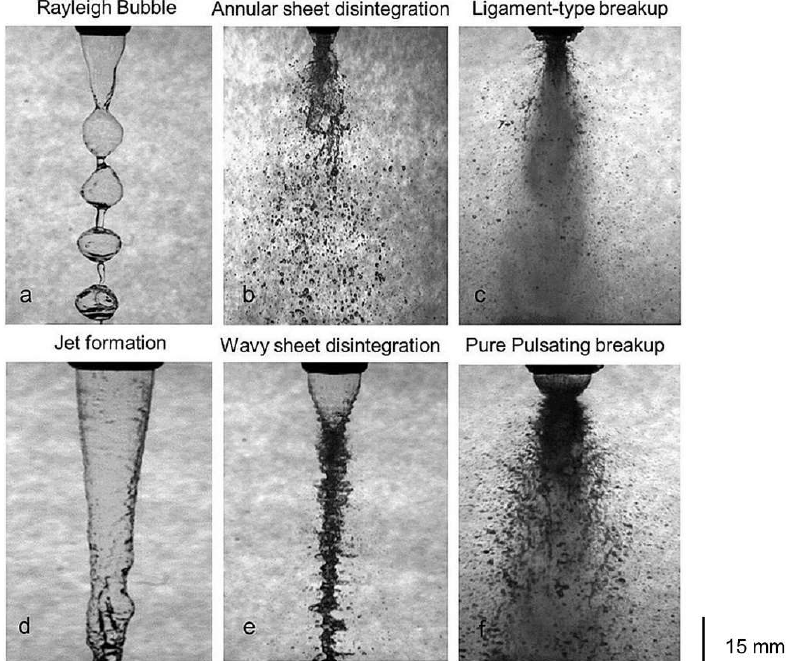
Figure 7. For the converging nozzle with 280 µ m sheet thickness at a 100 kg/h water flow rate ( Top row ) and at a 350 kg/h water flow rate ( Bottom row ), respectively, with airflow rates of ( a , d ) 1 kg/h, ( b , e ) 10 kg/h, and ( c , f ) 35 Kg/h,